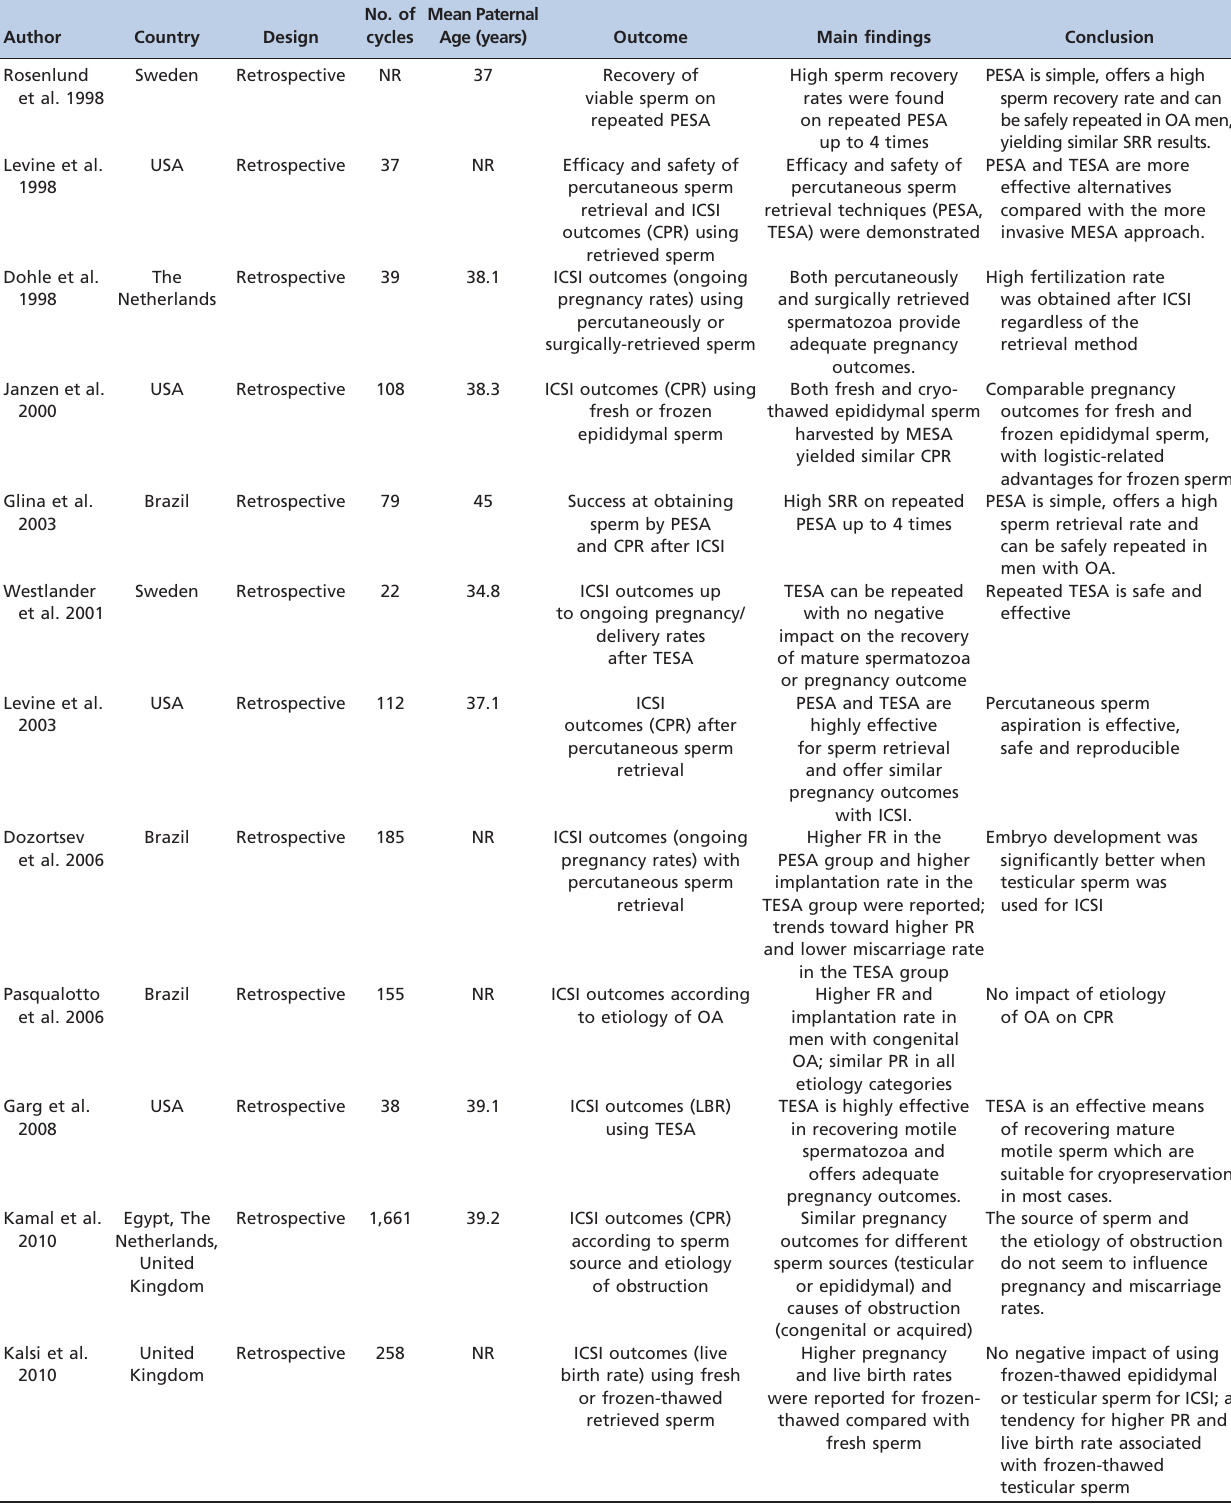
SRR: sperm retrieval rate; ICSI: intracytoplasmic sperm injection; IVF: in vitro fertilization; PESA: percutaneous epididymal sperm aspiration; TESA: testicular sperm aspiration; MESA: microsurgical epididymal sperm aspiration; FR: fertilization rate; PR: pregnancy rate; CPR: clinical pregnancy rate;